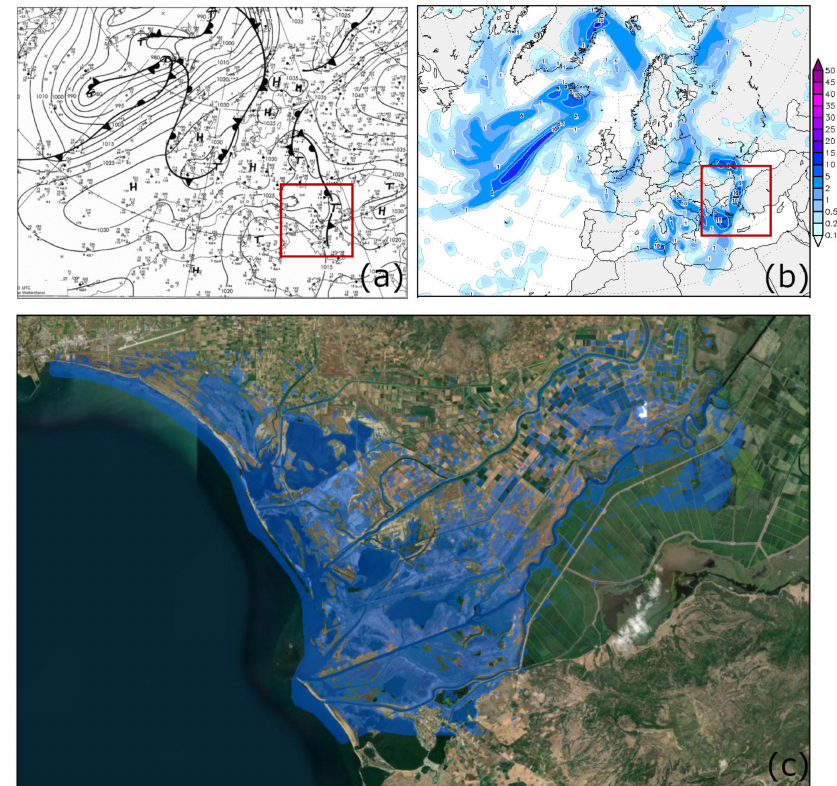
Figure A2. As in Figure A1, but for the 2006 flood event.